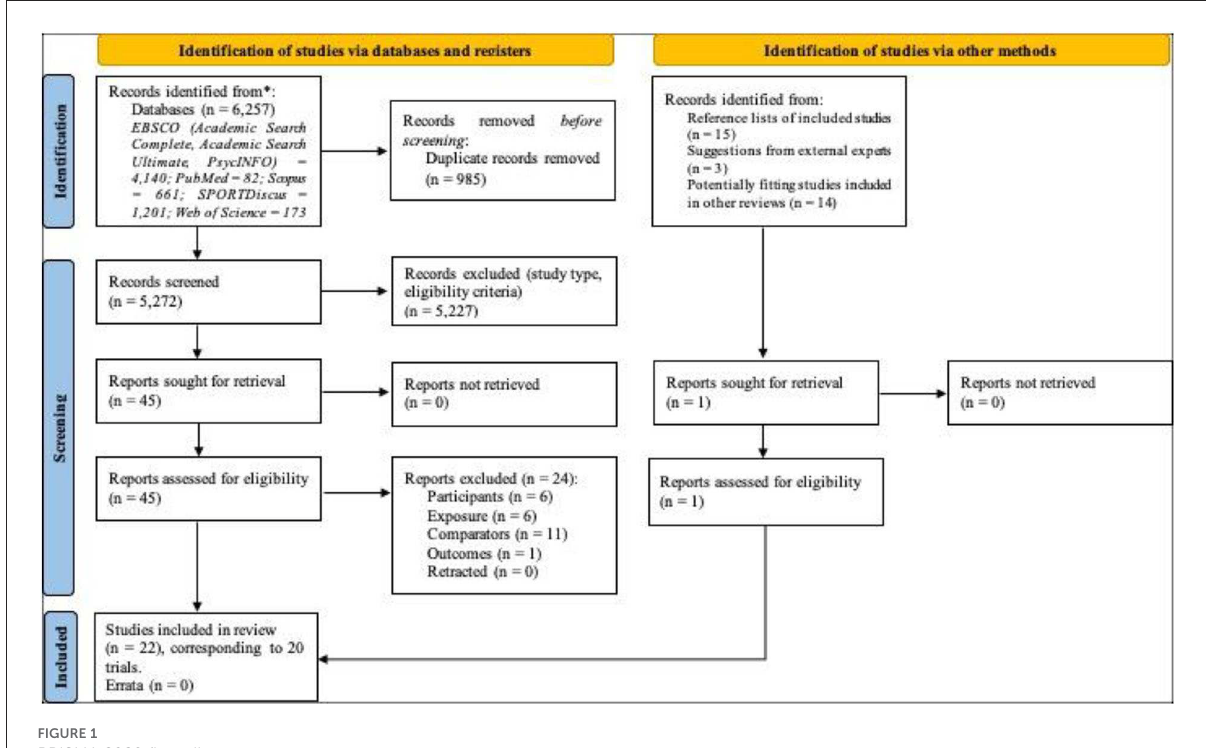
FIGURE1 PRISMA 2020 flow diagram.